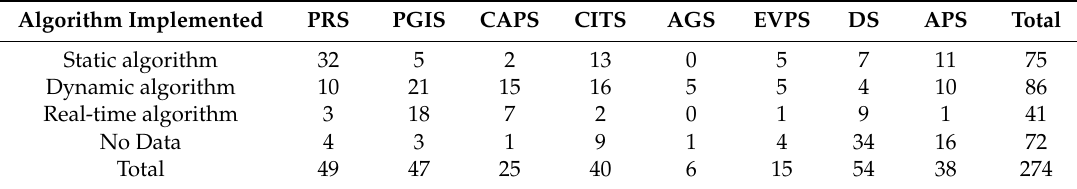
Table 13. Relationship between the types of algorithms implemented (rows) and the type of SPS